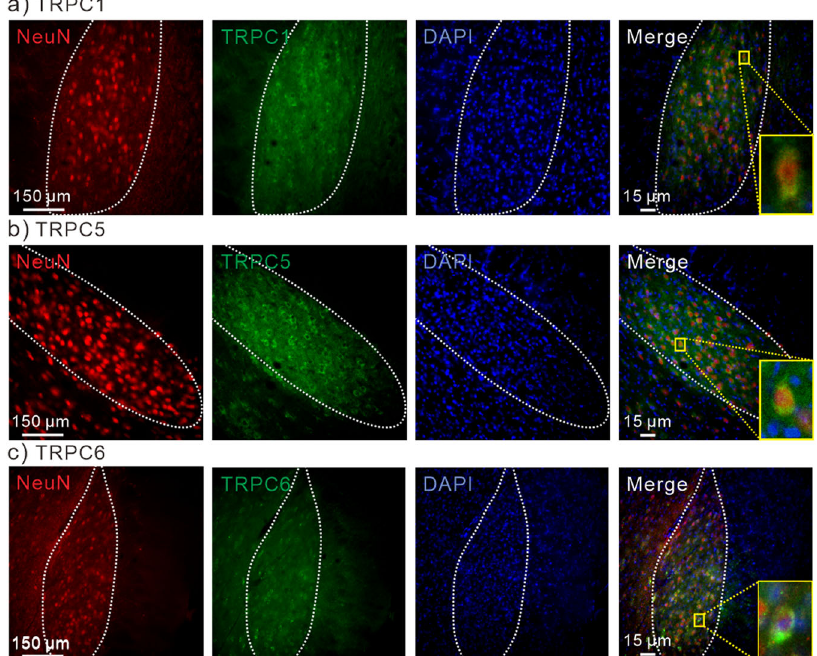
Fig. 6 TRPC1, 5 and 6 expression in STN of mice. a Immunostaining of NeuN (red), TRPC1 (green), DAPI (blue) and merged image in STN. Inset, enlarged merged image of a neuron. b Immunostaining of NeuN (red), TRPC5 (green), DAPI (blue) and merged image in STN. Inset, enlarged merged image of a neuron. c Immunostaining of NeuN (red), TRPC6 (green), DAPI (blue) and merged image in STN. Inset, enlarged merged image of a